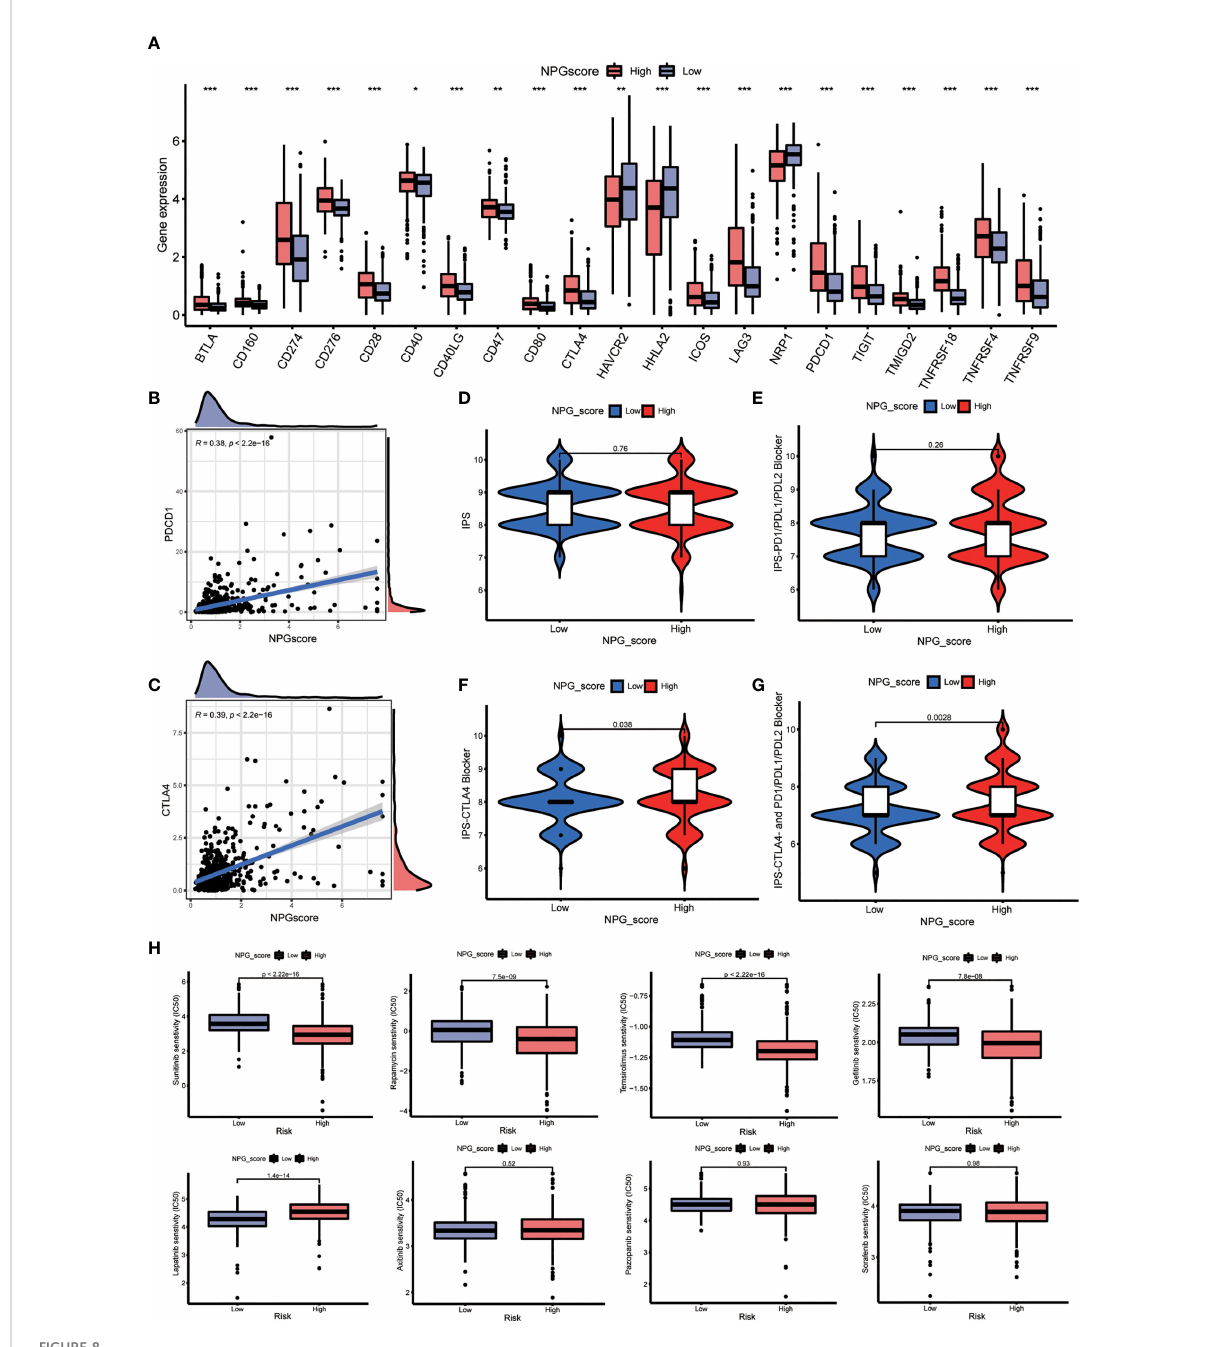
FIGURE 8 Therapeutic response prediction. (A) Comparison the difference of ICGs expression between high- and low-NPG score groups. (B, C) The relationship of NPG score and PDCD1 and CTLA4. (D – G) Correlation analysis between NPG score and response to immunotherapy. (H) Comparison of the sensitivities to the chemotherapy drugs currently used for ccRCC treatment. *P < 0.05; ** P < 0.01; *** P <